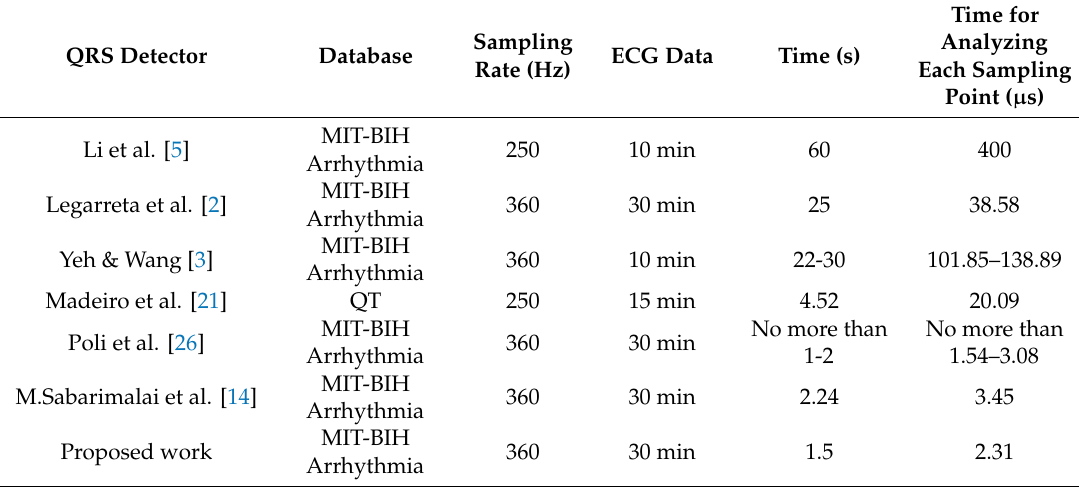
Table 7. Computation time comparison with other